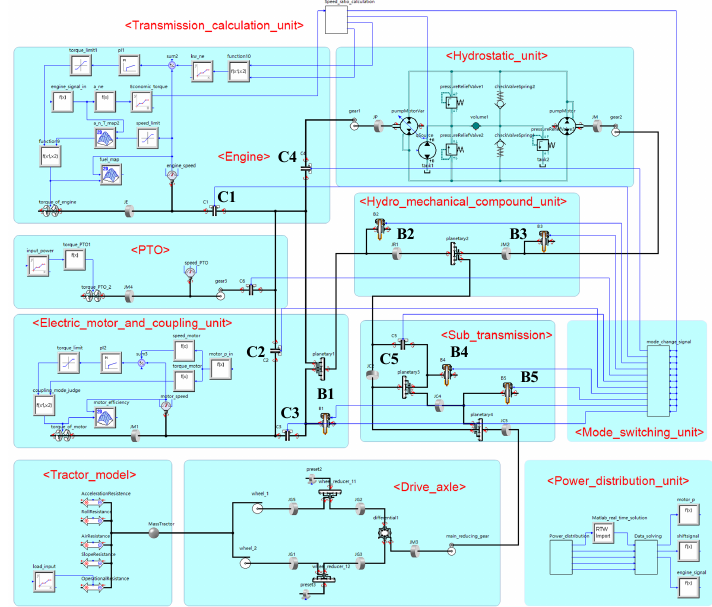
Figure 13. A tractor simulation model based on SimulationX.